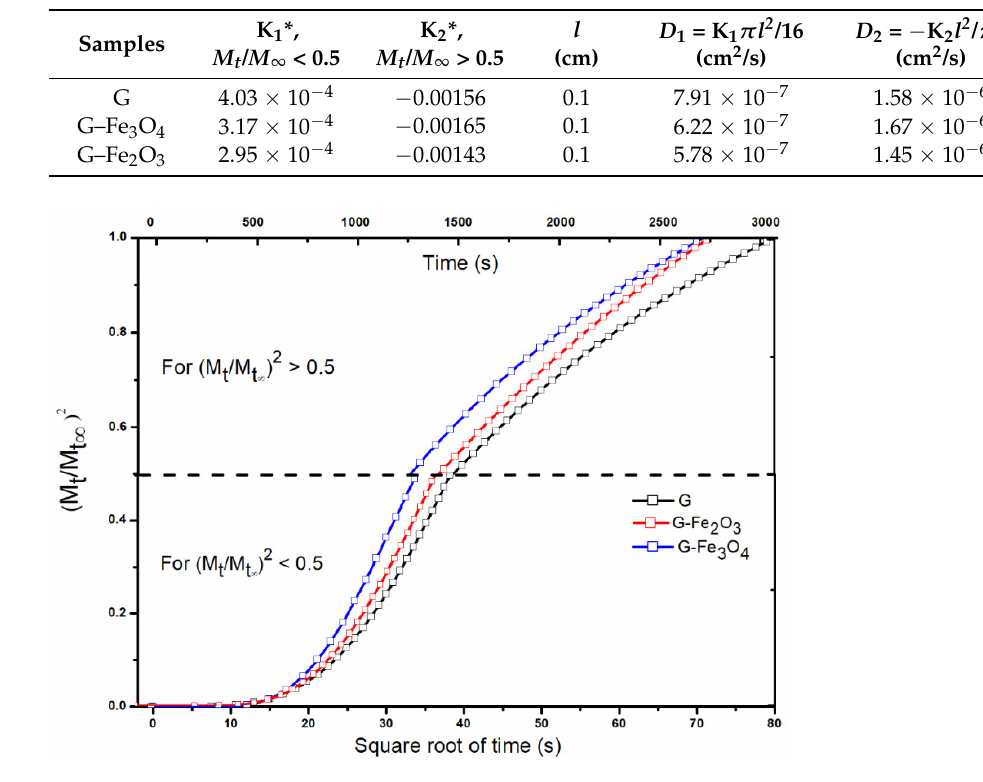
Figure 7. Normalized variation of the mass as function of time (G, G–Fe 2 O 3 and G–Fe 3 O 4 ). The slope of the graph Mt / M ∞ as a quadratic function at t 1/2 or the slope limit of the Table 4. The diffusion coefficients determined based on the experimental data for the analyzed samples. graph of ln (1 − Mt / M ∞ ) are shown in Figure